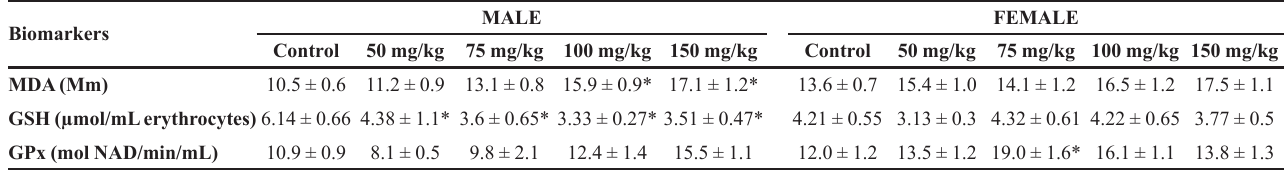
TABLE II - Oxidative stress biomarkers evaluated in male and female Wistar rats after 28 days of oral treatment with a mixture of p- synephrine, ephedrine, salicin and caffeine (10:4:6:80